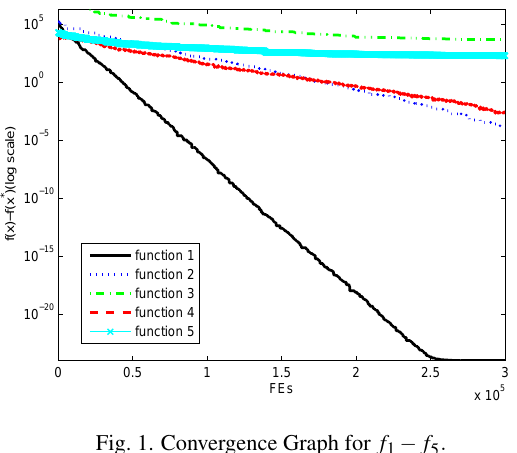
Fig. 1. Convergence Graph for f 1 − f 5 .